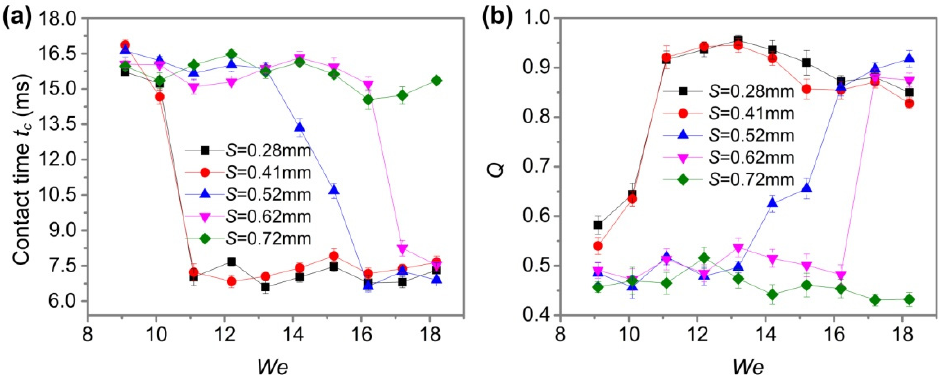
Figure 12. Contact time t c and Q of water droplets at different intervals S with the change of Weber number We : ( a ) Contact time t c ; ( b ) Q .